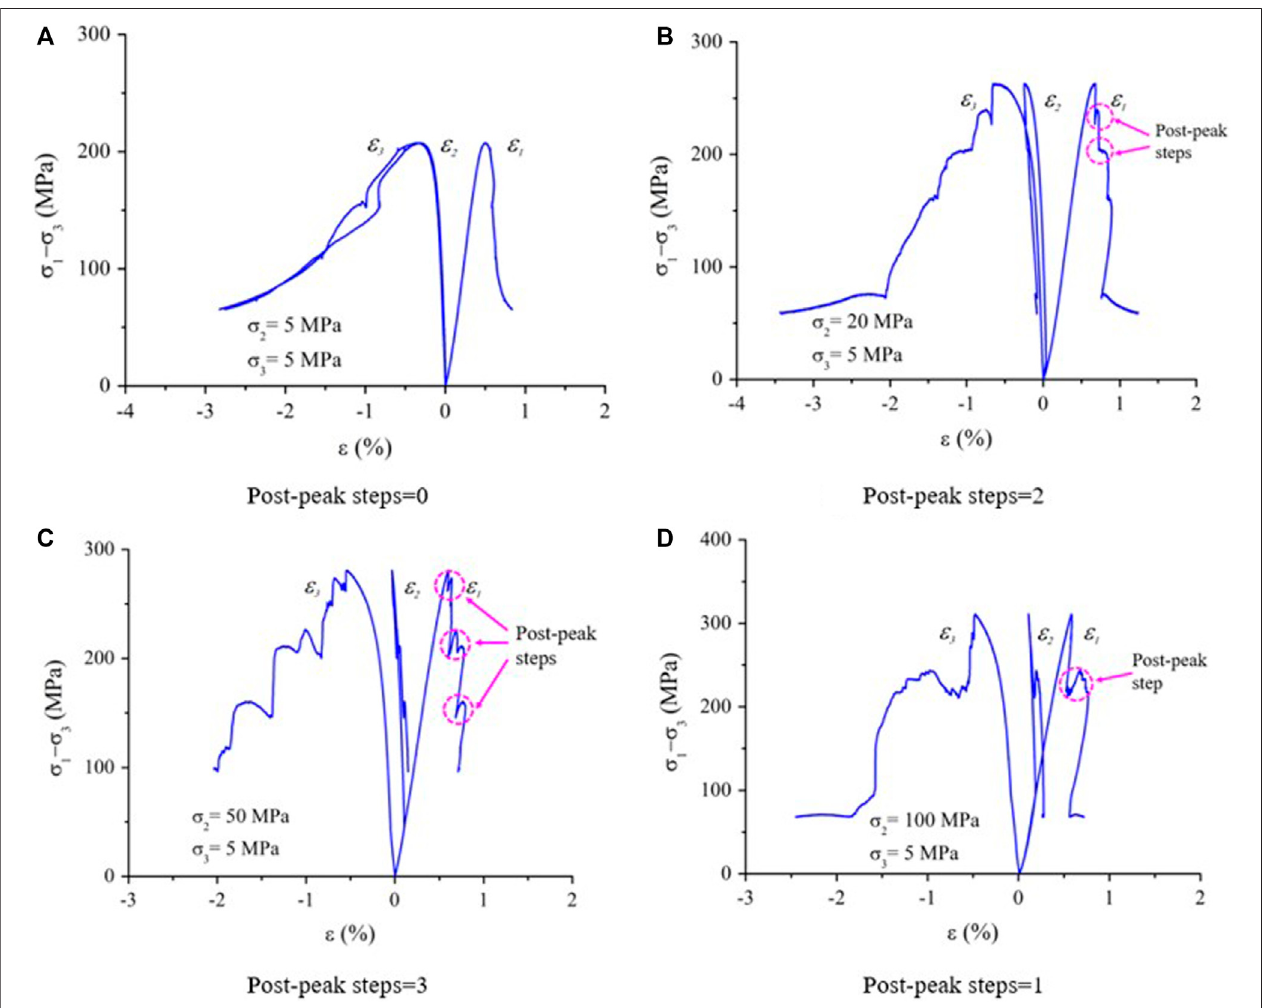
FIGURE4| Stepnumberatpost-peakincreases fi rstandthendecreaseswiththeincreasein σ 2 ( σ 2 =5 MPa).Thepost-peakstepsisindicatedbyadottedcirclein the fi gure.